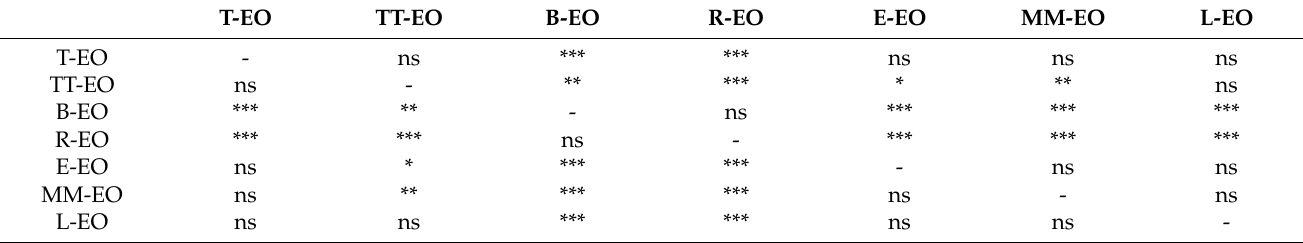
Table 7. Significance levels of differences in changes in pseudomonal biofilm cells viability after treatment with EOs in their liquid forms and volatile fractions obtained with three methods. The differences were statistically significant for p < 0.05 and are referred to as p < 0.03 (*), p < 0.006 (**), p < 0.00003 (***); ns refers to difference being statistically insignificant. T-EO, thyme oil; TT-EO, tea tree oil; B-EO, basil oil; R-EO, rosemary oil; E-EO, eucalyptus oil; MM-EO, menthol mint oil; L-EO, lavender